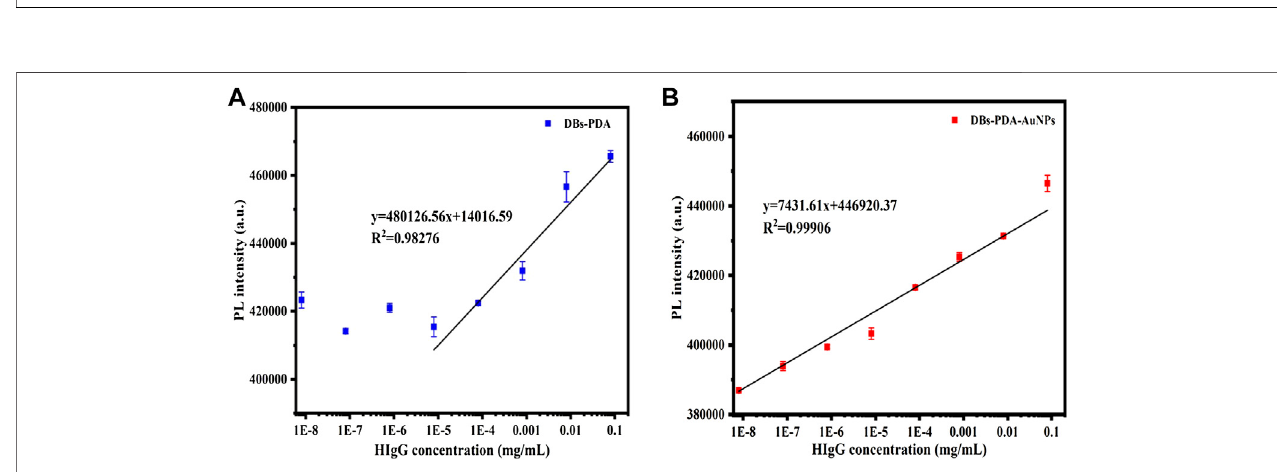
FIGURE 10 | PL peak intensity variations of (A) DBs-PDA and (B) DBs-PDA-AuNPs versus the HIgG concentration with a coef fi cient of determination ( R 2 ) of 0.98276 and 0.99906, respectively. Excitation wavelength was 360 nm.